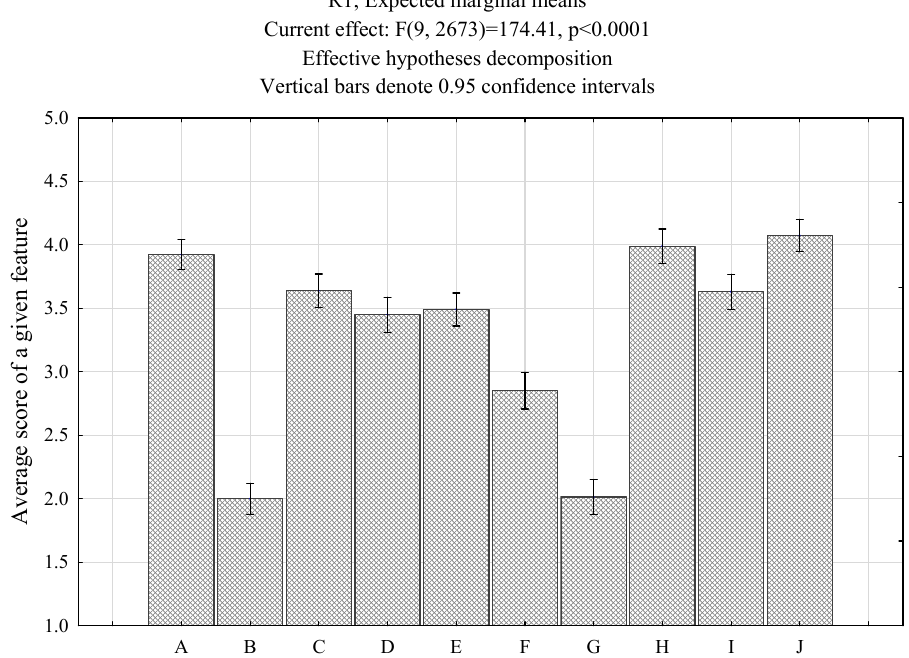
Figure 2. The most important criteria the respondents follow when buying a power bank (A—Price, B—Product appearance in advertisements, C—Opinions of other users, D—Opinions on online forums, E—Availability, F—Information on the packaging, G—Additional functions of power bank, e.g., built-in flashlight, H—Feature of quick charging of target devices, I—Possibility of simultaneous charging of multiple devices, J—Feature of quick charging of the power bank).